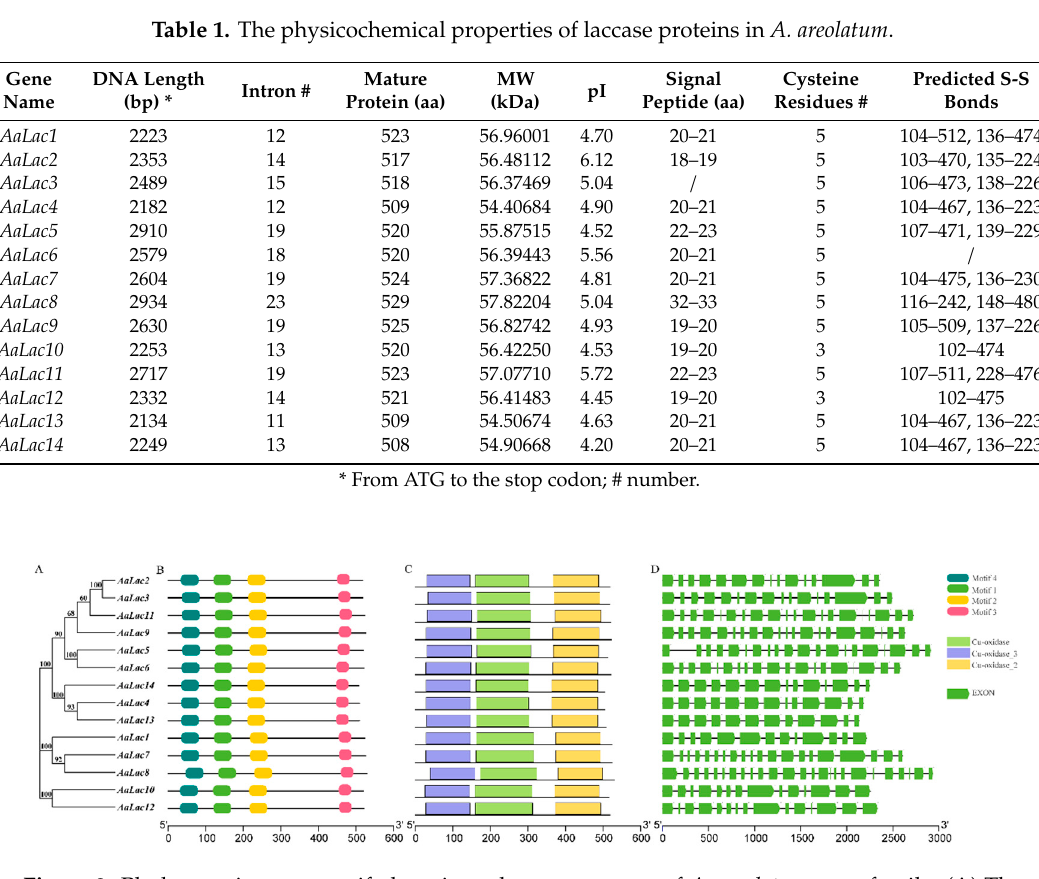
Figure 2. Phylogenetic trees, motif, domain and gene structure of A. areolatum gene family. ( A ) The phylogenetic tree of AaLac genes; ( B , C ) conserved motifs and domains of the AaLac proteins, different colors represent different motifs or domains. ( D ) exon-intron structures, exons are indicated by green boxes and introns by lines.